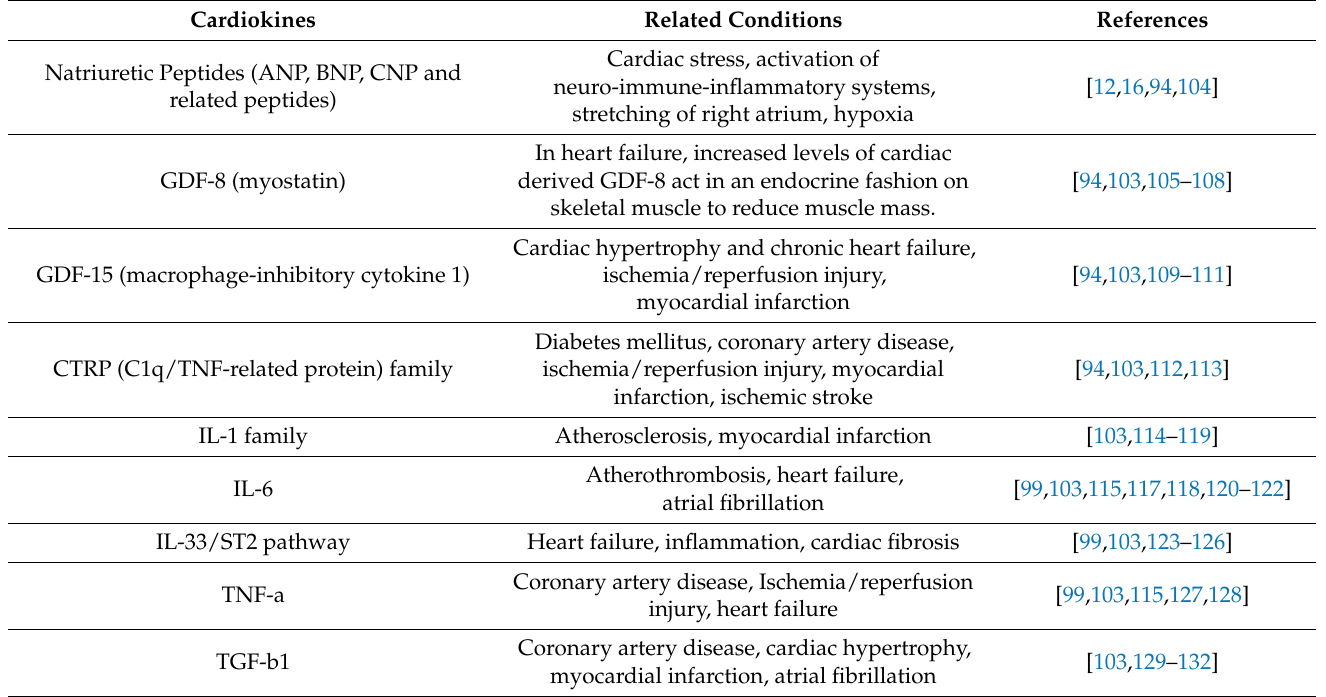
Table 3. Biological and pathophysiological characteristics of the most studied